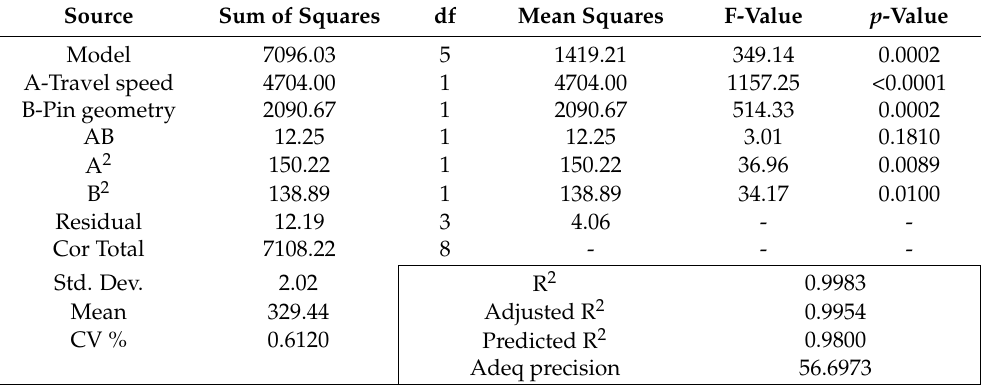
Table 5. ANOVA for PZ temperatures of AA1050 BT-FSP specimens.